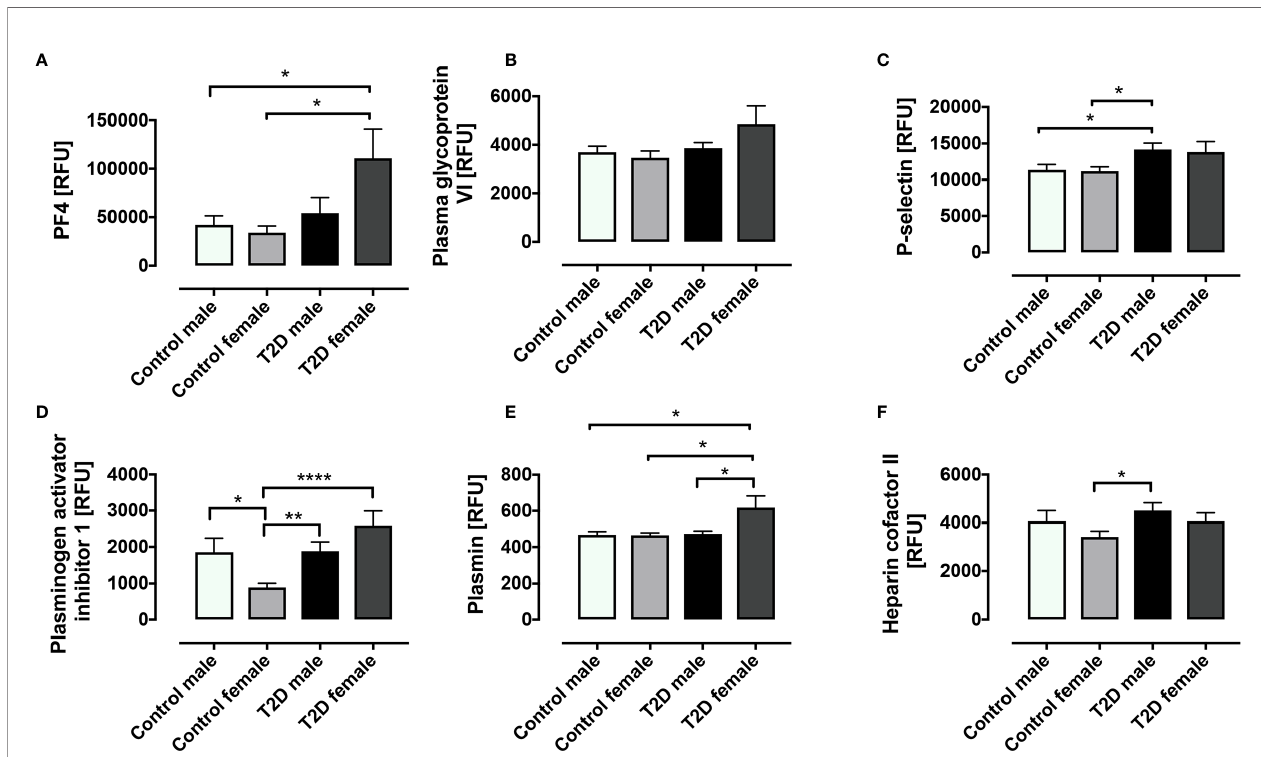
FIGURE 2 | Circulatory levels of platelet related proteins in obese type 2 diabetes (OT2D) and control subjects strati fi ed according to gender. Plasma protein levels of platelet factor 4 (PF4) (A) , platelet glycopsrotein VI (PGVI) (B) , P-selectin (C) , plasminogen activator inhibitor I (PAI-1) (D) , plasmin (E) , plasmin and heparin cofactor II (F) . RFU: relative fl uorescent units; *p < 0.05; **p < 0.01; ****p <